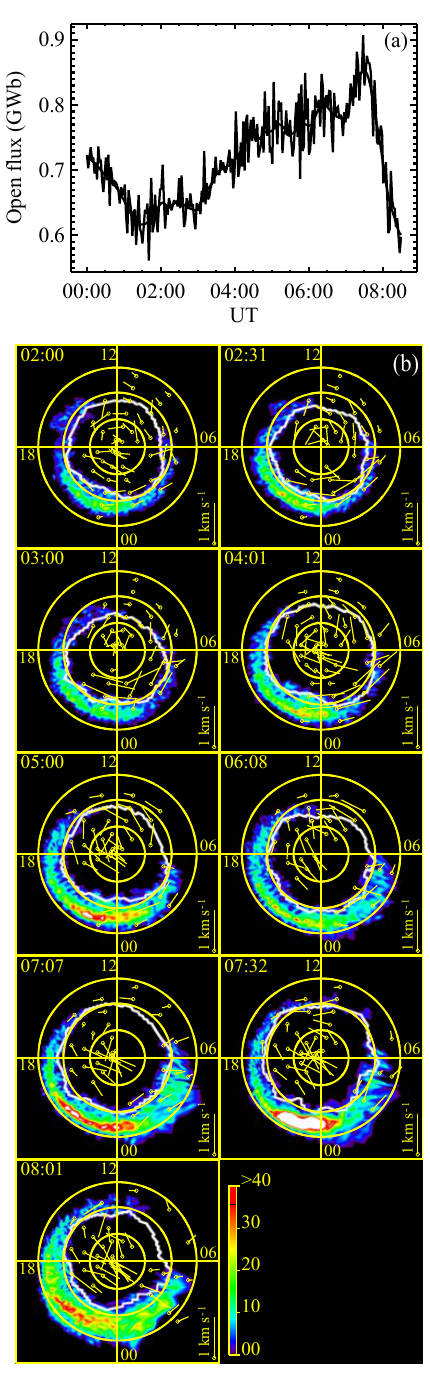
Figure 11. Open magnetic flux estimated using the SI12 images of the Earth’s proton aurora on 26 January 2001, in the same format as Figs. 3 and 7. The average of the SuperDARN measurements of the ionospheric velocity over the polar caps shown is, in chronological order, 332, 424, 412,477, 498, 416, 354, 468 and 444ms − 1